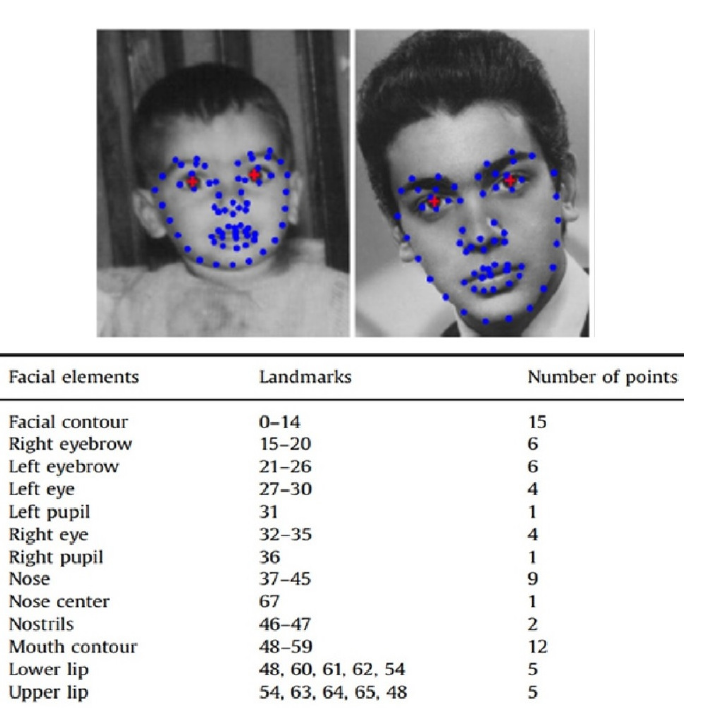
Figure 1. 68 facial landmark